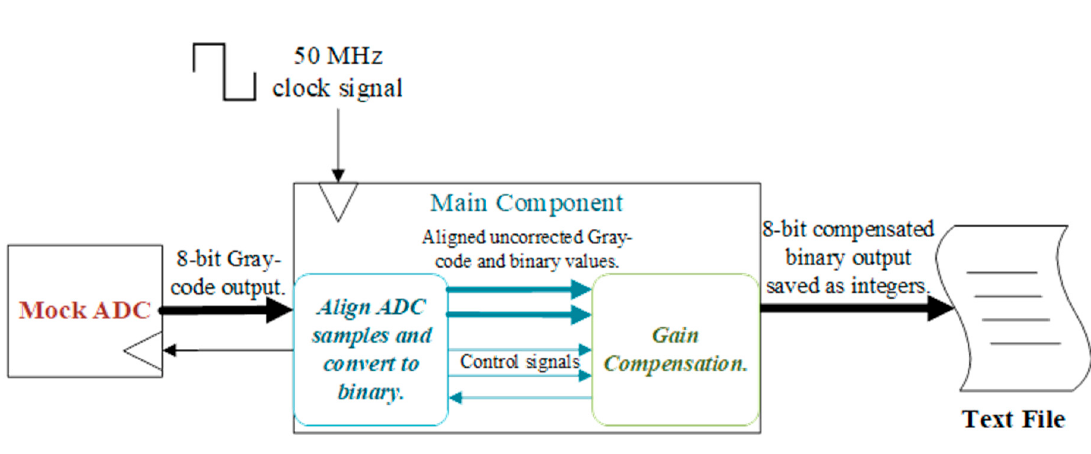
Figure 8. Testing the ADC output without applying the compensation algorithm.